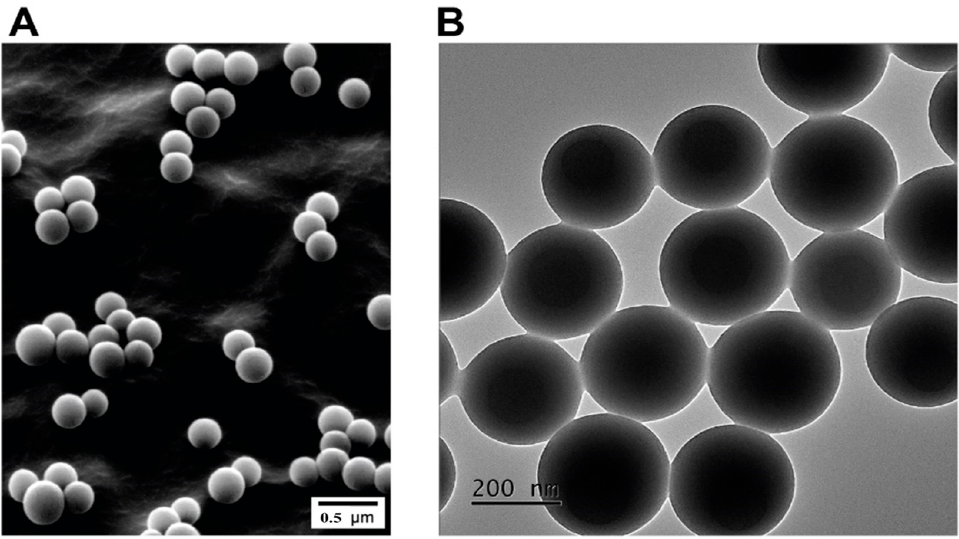
Figure 2. ( A ) Scanning electron microscopy image of P(St/AA) particles. ( B ) Transmission electron microscopy images of P(St/AA) particles.